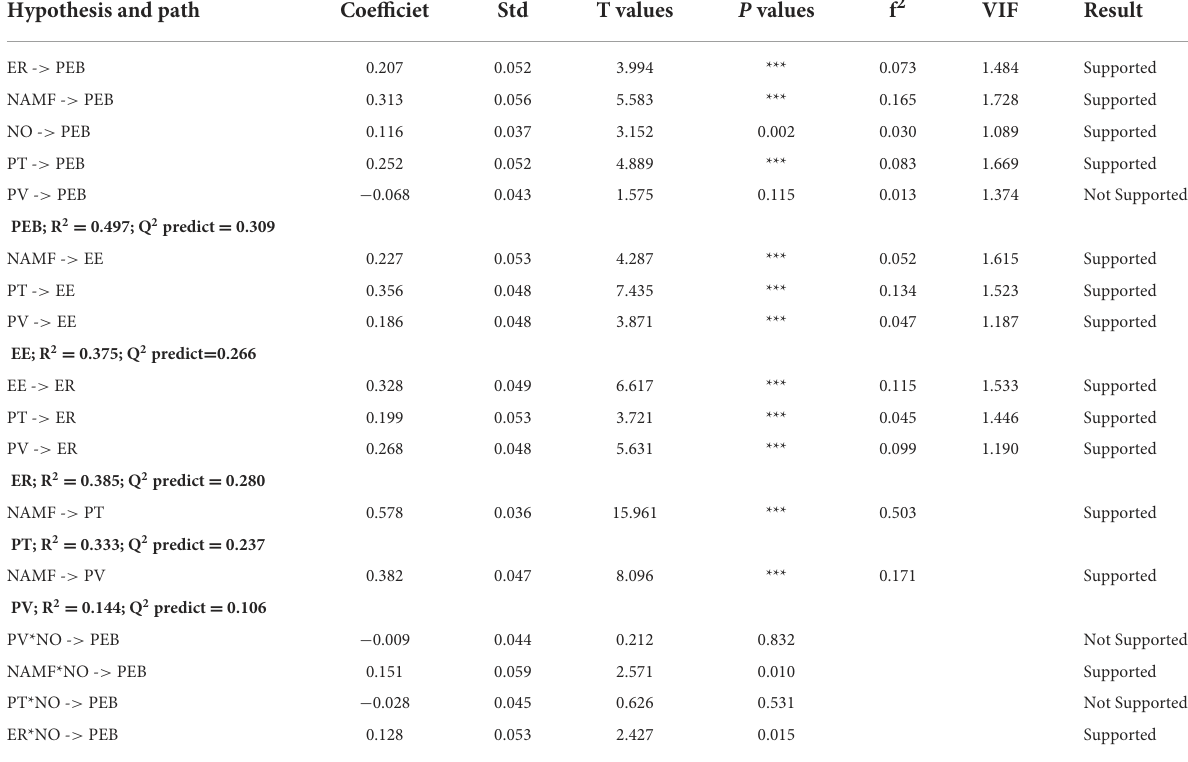
TABLE 5 Assessment of structural